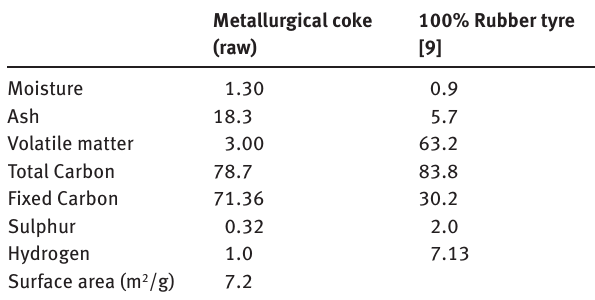
Table 1: Chemical compositions (wt pct) of carbonaceous materials